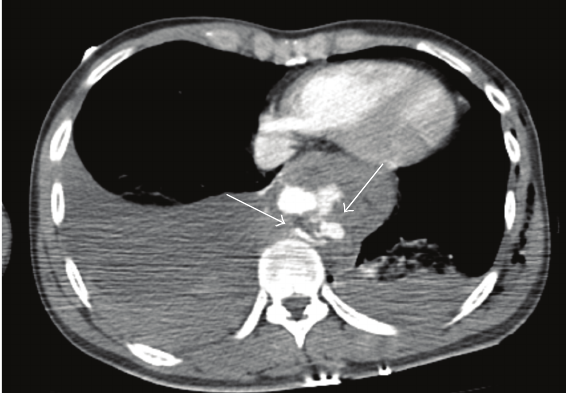
Figure 2: Contrast-enhanced axial chest CT using the mediastinal window settings shows hematoma surrounding trachea posteriorly and aorta circumferentially in the posterior mediastinum.